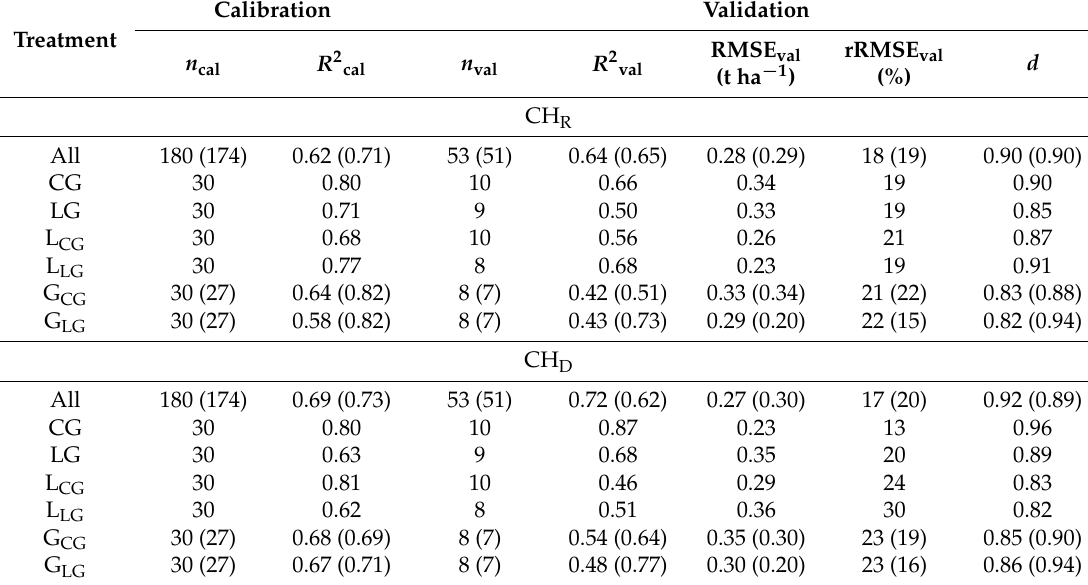
Table 3. Linear regression analysis of calibration (cal) and validation (val) dataset between dry matter yield and manual height measurements (CH R ) as well as UAV-based RGB imaging (CH D ) for the whole dataset (All) and the different treatments: clover-grass (CG), lucerne-grass (LG) as well as the pure stands of legumes (L CG , L LG ) and grass (G CG , G LG ) of the mixtures, respectively. n = number of samples; R 2 = coefficient of determination; RMSE = root mean square error; rRMSE = relative RMSE; d = Willmott’s refined index of agreement. Values in brackets represent results for the dataset without pure grass swards of the second